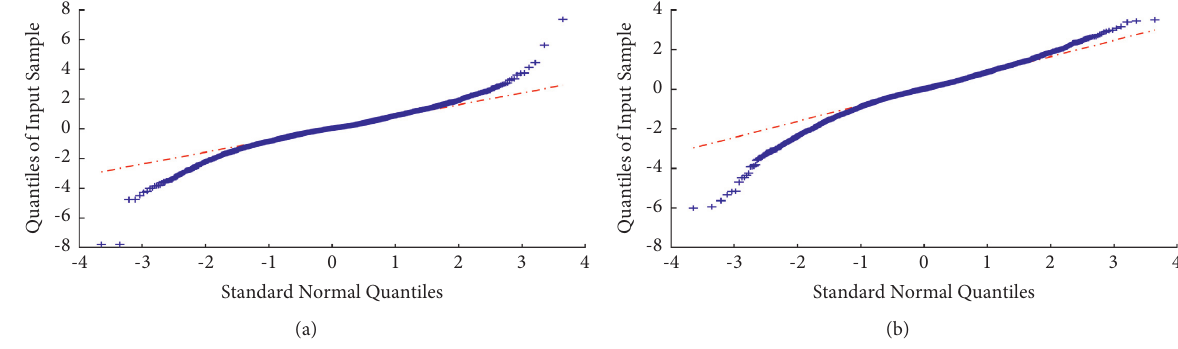
Figure 4: QQ plots of the standardized residuals z